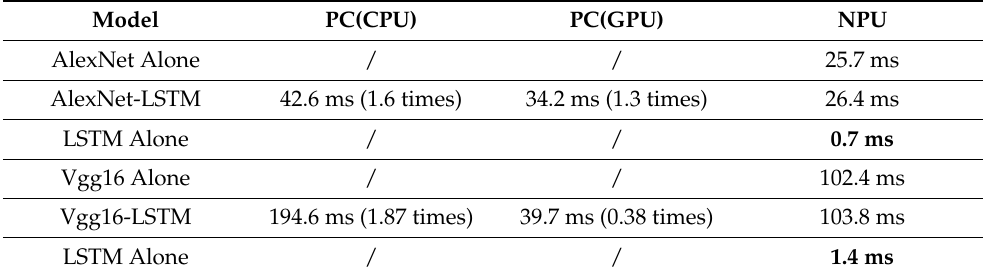
Table 9. Comparison experiment of running